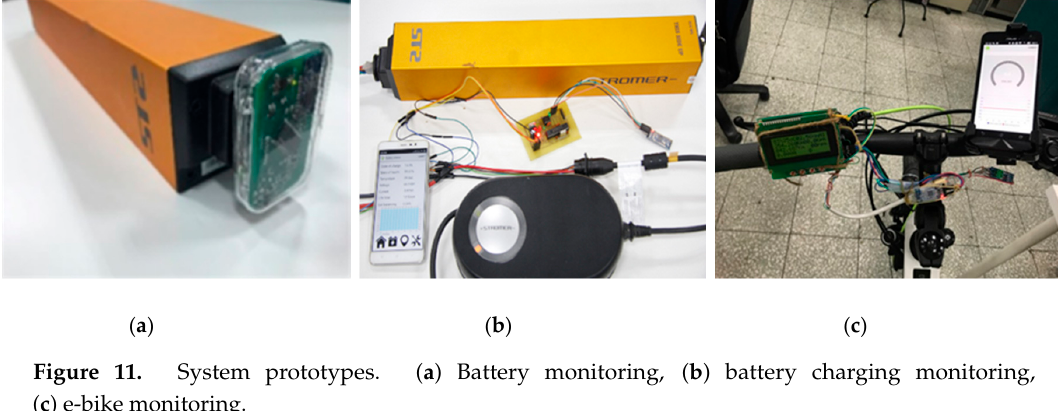
Figure 10. EMS App prototypes. ( a ) Aggregate monitor, ( b ) battery monitor, ( c ) history data report.